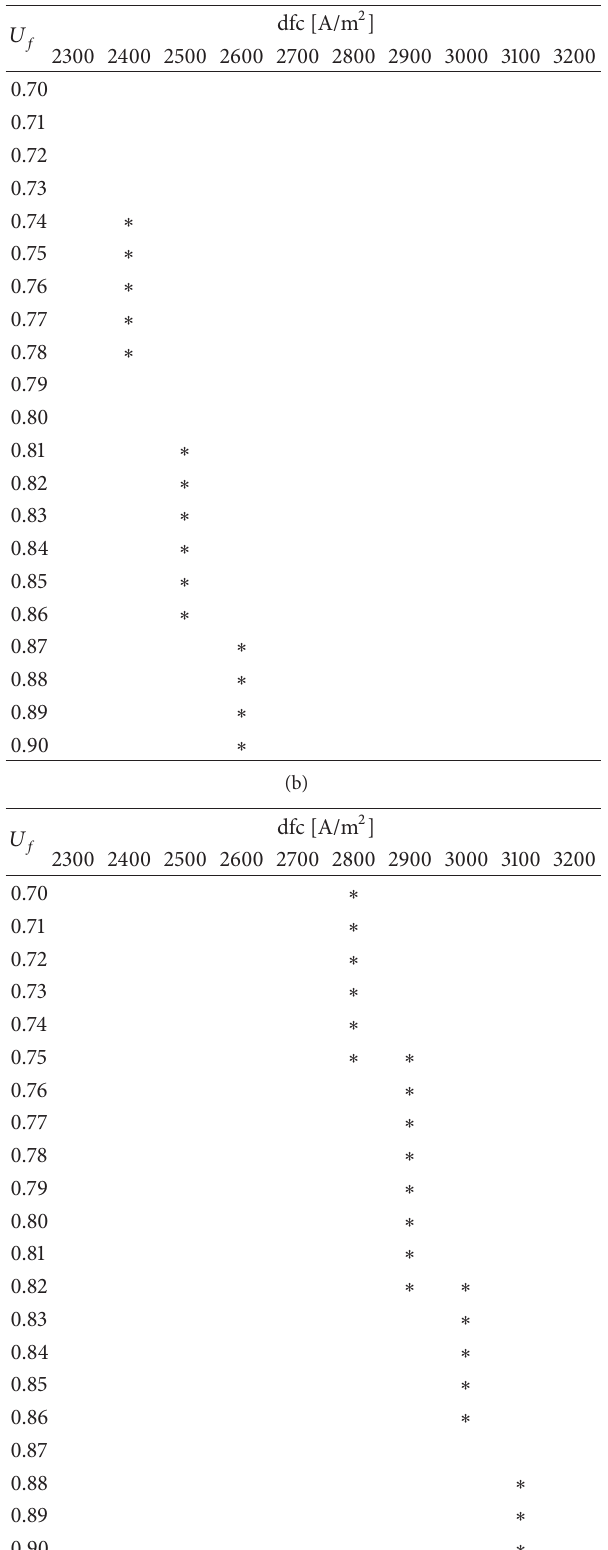
Table 3: Fall of temperature for increasing 𝑈 𝑓 for base system. dfc [ A / m 2 ]